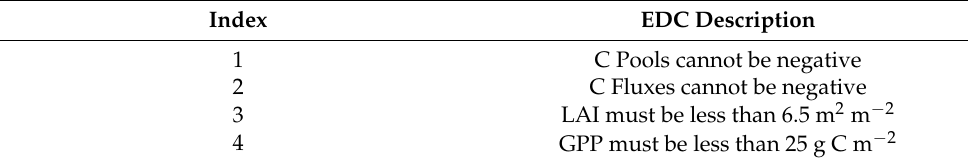
Table 2. DALEC-Crop Ecological and Dynamic Constraints